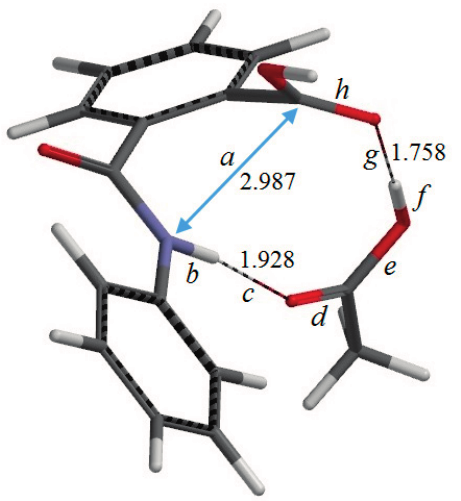
Figure 3. The geometry of the reactant complex RC (complex between phthalanilic acid and acetic acid). Selected interatomic distances are shown in Å. Also shown are the definitions of interatomic distances a – h